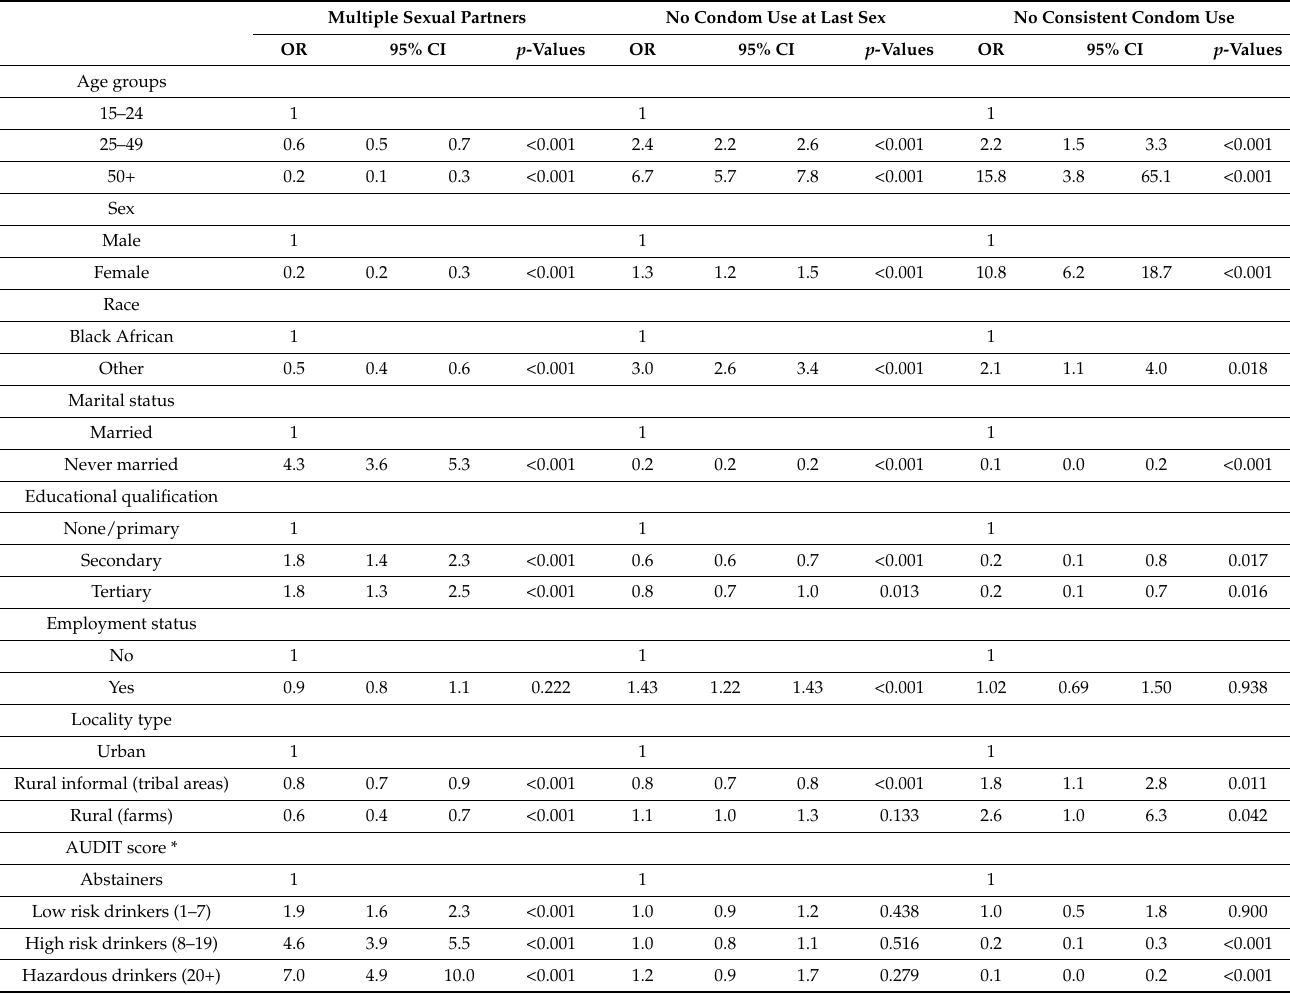
Table 4. Unadjusted odds ratios for risky sexual behaviours by socio-demographic factors among individuals 15 years older, South Africa 2017 survey. Multiple Sexual Partners No Condom Use at Last Sex No Consistent Condom